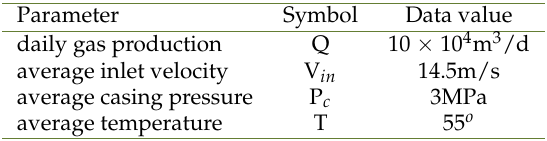
Fig. 7. Grid division diagram of plunger.